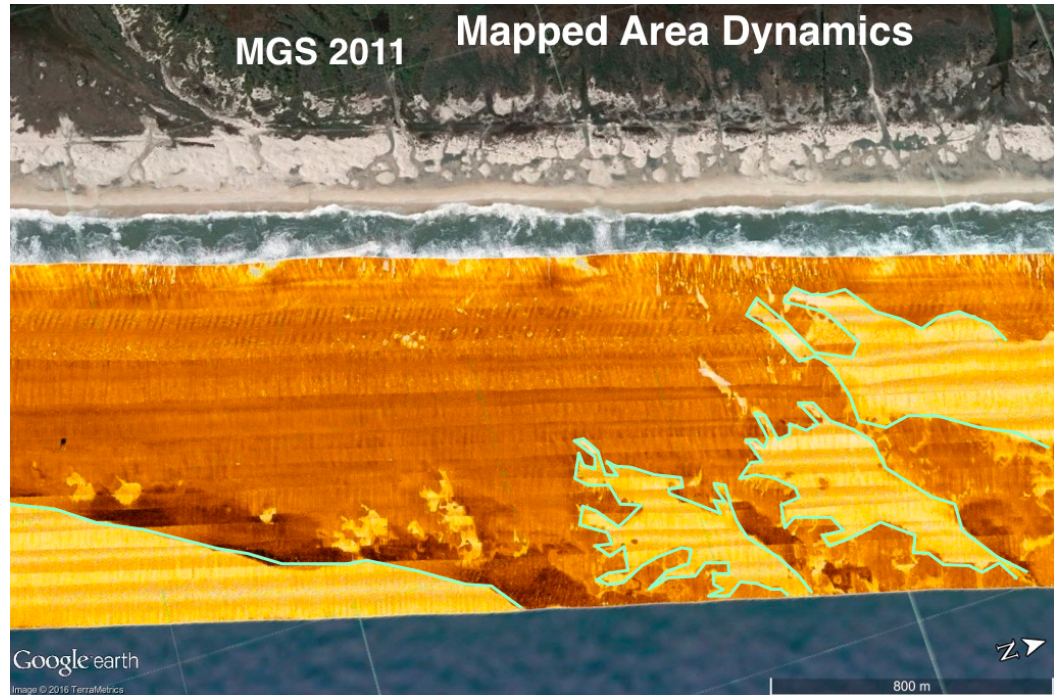
Figure 10. Side-scan mosaic and classification shapefiles based on 2011 survey data.